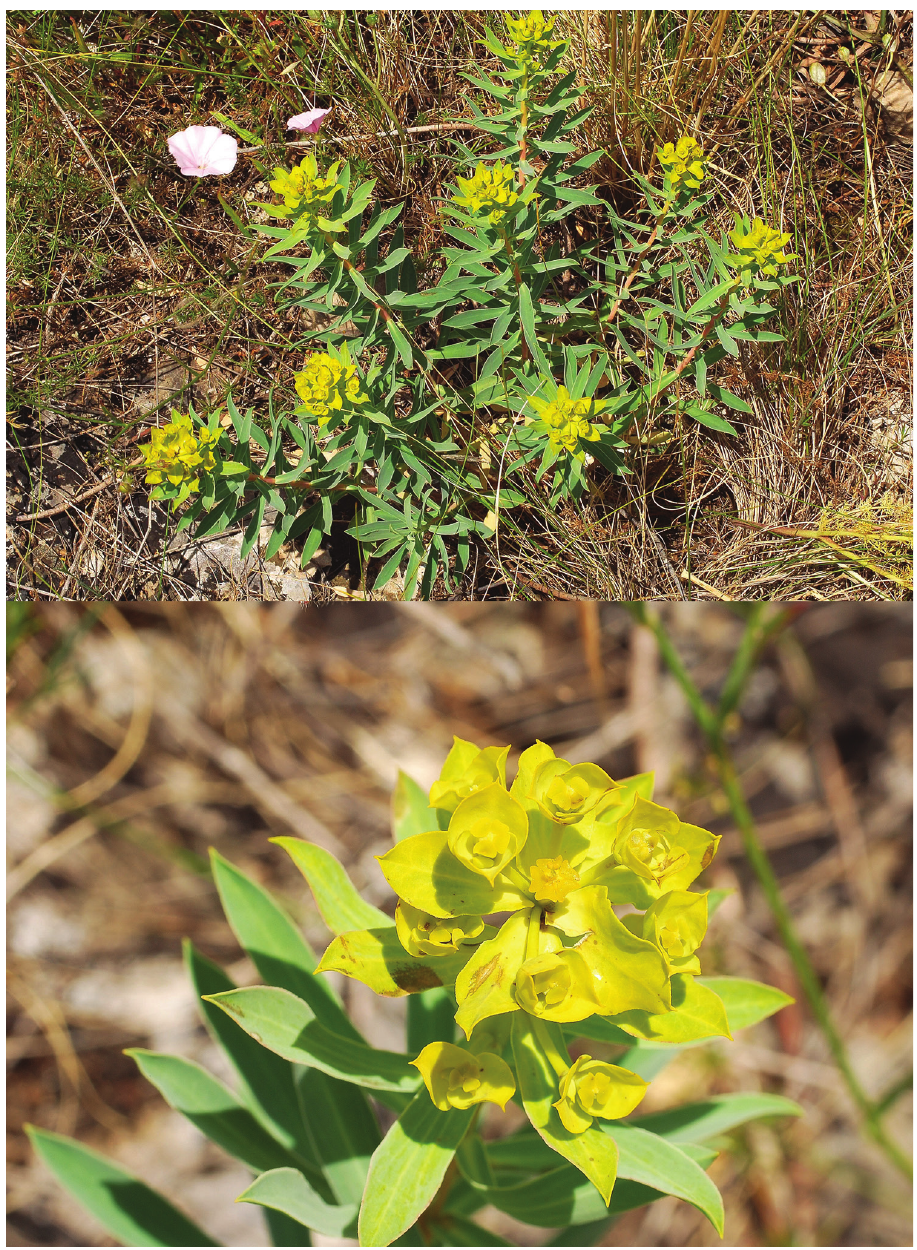
Figure 3. Euphorbia nicaeensis subsp. japygica photographed in National Park of Alta Murgia (Altamura). Photograph by E.V.